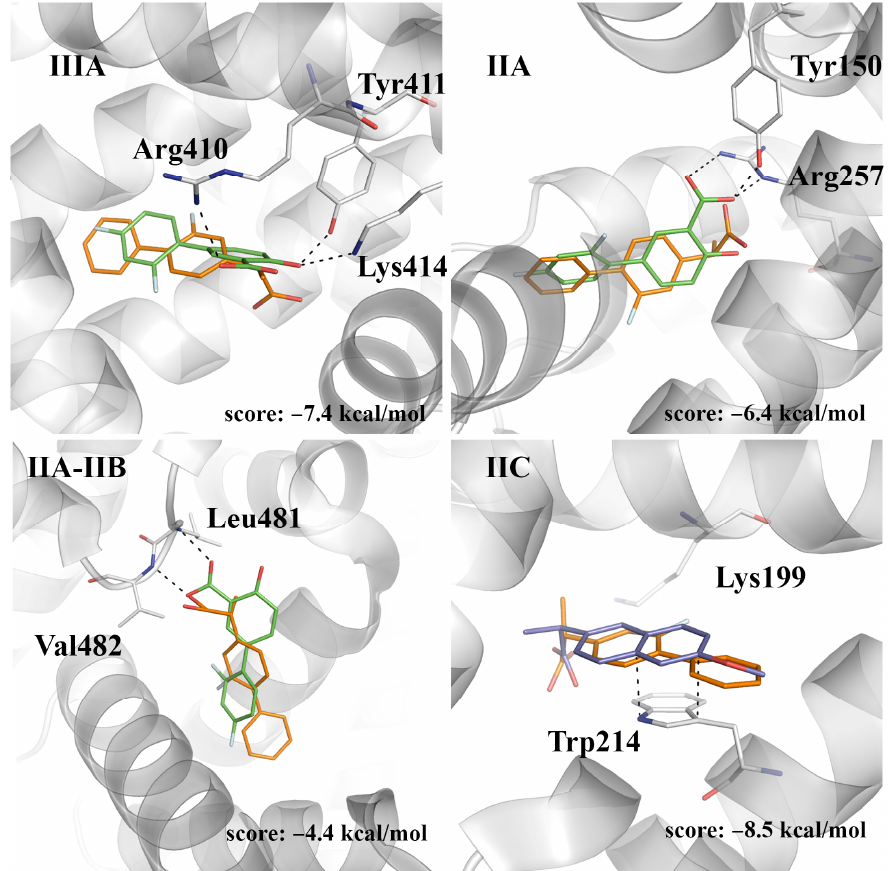
Figure 7. The predicted pose of ( R )-flurbiprofen bound to sites IIIA, IIA, IIA-IIB, and IIC. The crystallographic poses of diflunisal (bound at sites IIIA, IIA, and IIA-IIB; PDB entry 2BXE) and ( S )-naproxen (bound at site IIC; PDB entry 4OR0) are shown as sticks (C atoms in green and dark blue, respectively). The docked pose of ( R )-flurbiprofen is shown with C atoms as orange sticks. The protein backbone is displayed as a gray cartoon. Selected interactions with HSA residues are represented as dashed lines.